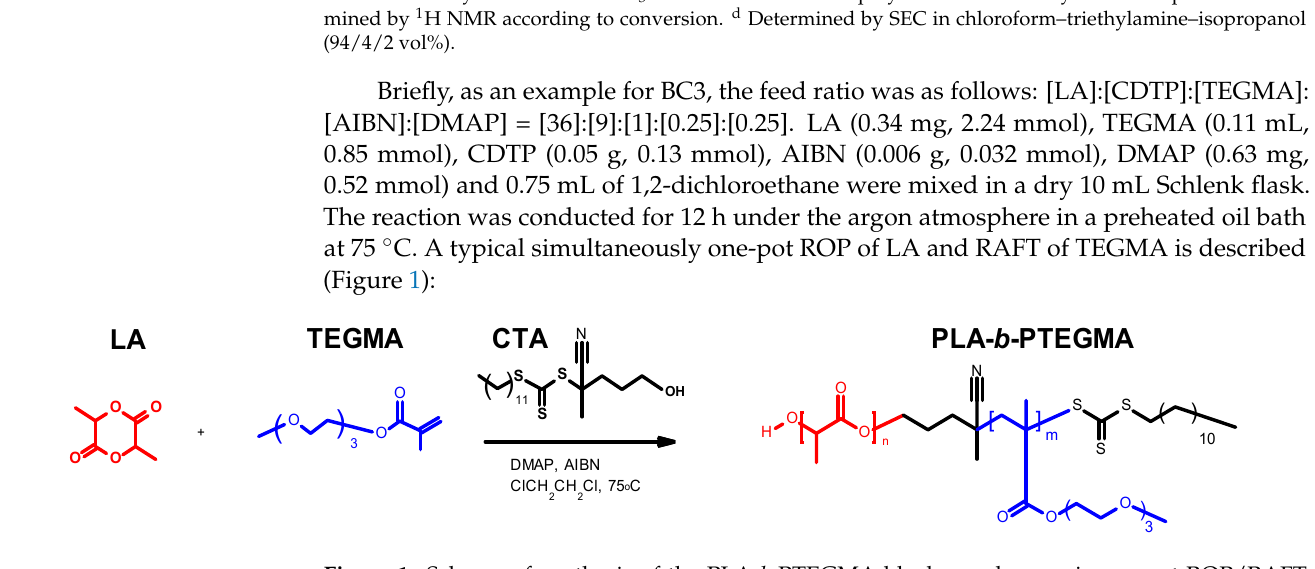
Figure 1. Scheme of synthesis of the PLA- b -PTEGMA block copolymer via one-pot ROP/RAFT polymerization. (LA = lactide; TEGMA = Triethylene glycol methyl ether methacrylate; CTA = chain transfer agent; PLA- b -PTEGMA = poly(lactide)- b -poly(triethylene glycol methyl ether methacrylate.) The conversion was calculated using 1 H NMR spectra from the integral intensities of respective monomer and polymer signals. The final (co)polymers were purified by dialysis against acetone using a molecular weight cut-off (MWCO) of 2 kDa. The